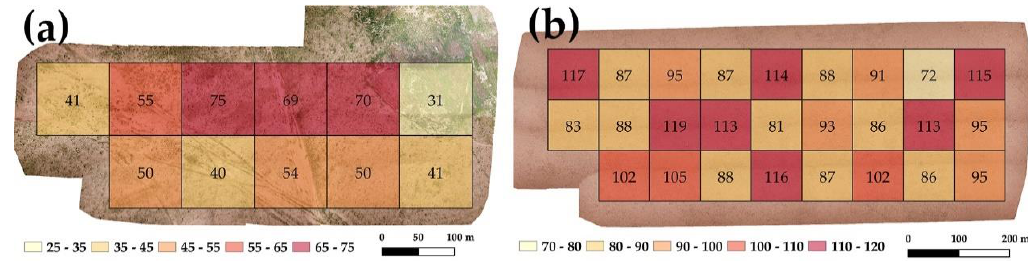
Figure 7. Shrub counts of each region in the ( a ) TSA; ( b ) DSA.